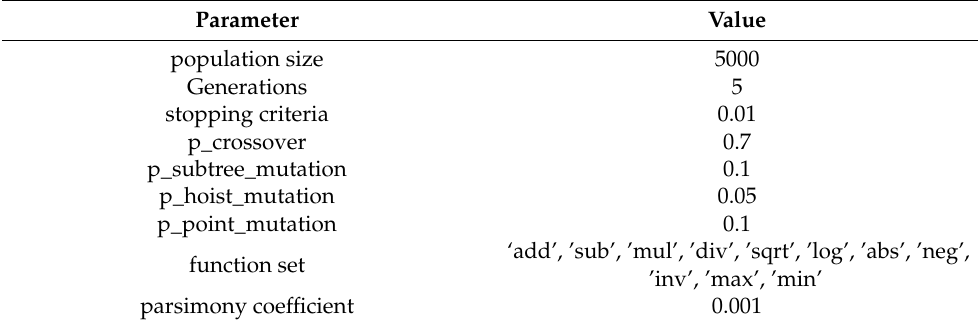
Table 1. The experimental setup of hyper-parameters in SR